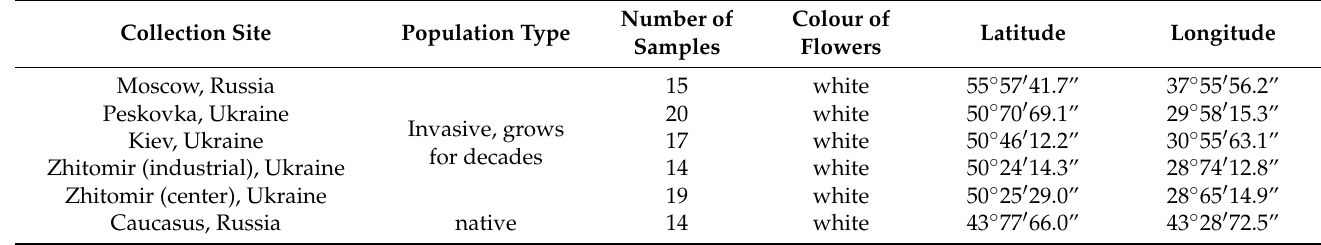
Table 2. Phenotypes, collection sites and population types of the H. sosnowskyi